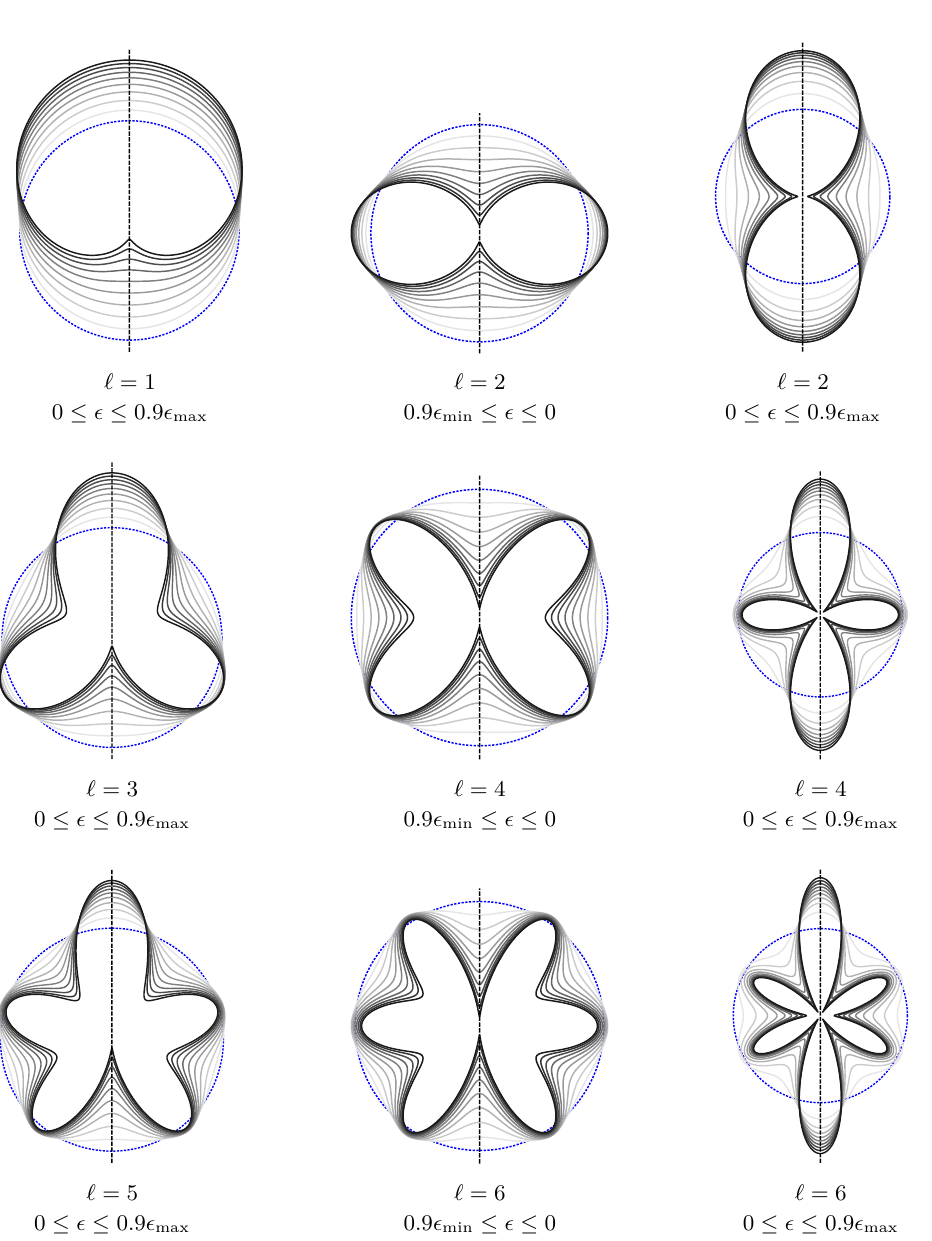
Figure 2. Cross-sections of the geometries we consider; these should be rotated around the dotted axis to generate the corresponding deformed sphere. The dotted blue circle is the unperturbed sphere; from light to dark gray, each curve corresponds to (cid:15) ranging in steps of 0 . 1 (cid:15) max (or 0 . 1 (cid:15) min ) from 0 . 1 (cid:15) max ( 0 . 1 (cid:15) min ) to 0 . 9 (cid:15) max ( 0 . 9 (cid:15) min ). For odd ‘ , negative (cid:15) is related to positive (cid:15) by a parity transformation which turns the cross-section “upside-down”, leaving the geometry